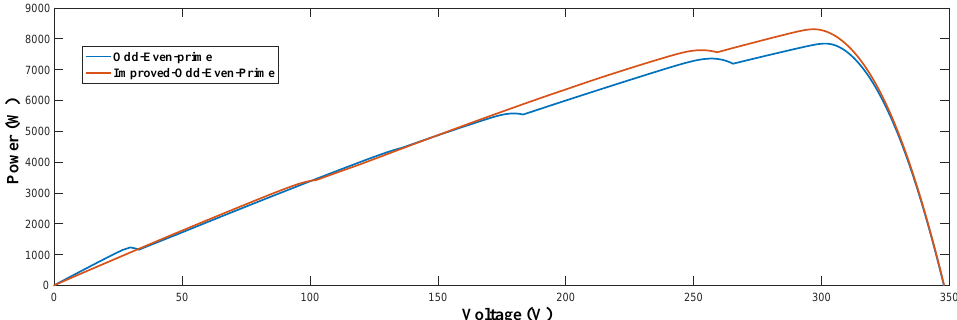
Figure 25. Voltage–power characteristics of 8 × 9 PV array for case-5 (Top-Left and Bottom-Right)